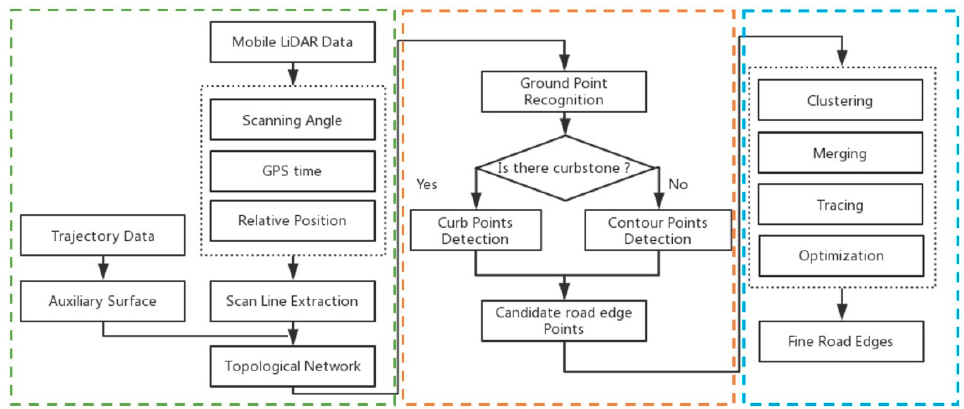
Figure 1. A framework for the extraction of road edges from the MLS data.